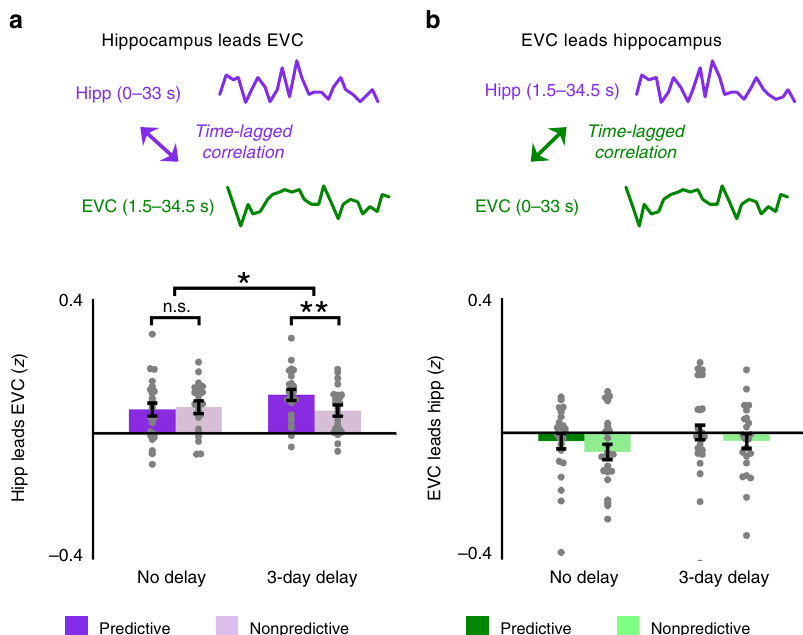
Fig. 6 Time-lagged background connectivity. a Hippocampus leads EVC: For each block we computed the correlation between earlier background activity in the hippocampus (0 – 33 s) with later background activity in EVC (1.5 – 34.5 s); a similar pattern of results emerged as for non-shifted background connectivity. b EVC leads hippocampus: For each block we correlated earlier background activity in EVC (0 – 33 s) with later background activity in the hippocampus (1.5 – 34.5 s); there were no reliable differences among conditions. Error bars indicate ± 1 SEM of the difference between predictive and nonpredictive actions at each timescale. ** p < 0.01; * p < 0.05 (paired t -tests). Source data are provided as a Source Data fi le